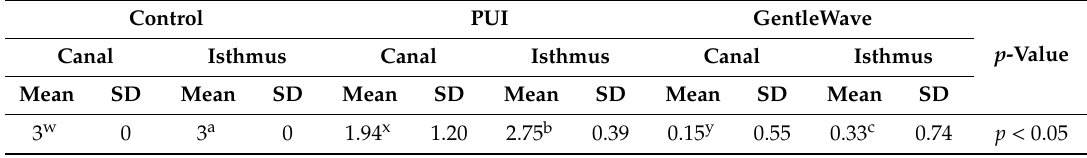
Table 1. Mean scoring data (Mean N ± SD) evaluated at main canal and isthmus of each group.